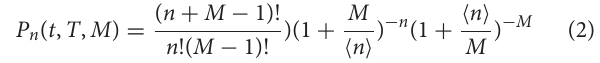
FIGURE 3 | (A) Poisson distribution for four different average values of photon counts number of thermal modes for the average number of 10 photons. (C) Thermal field photocount distribution (with similar number of modes M